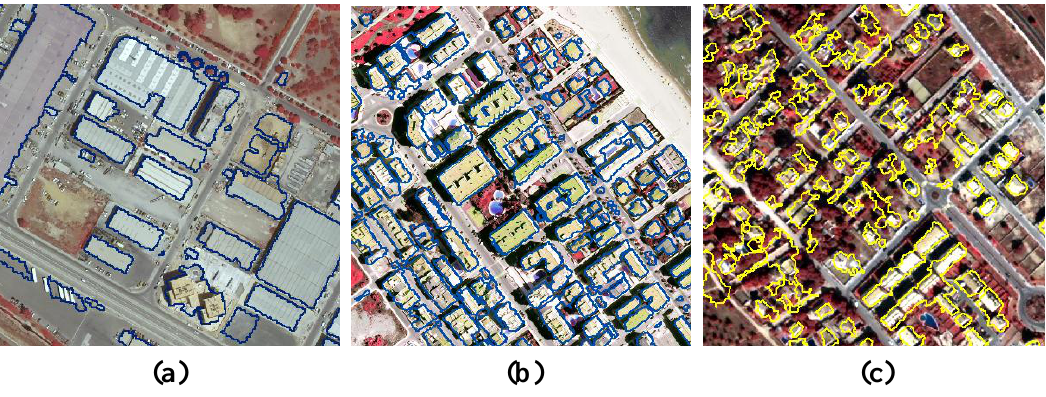
Figure 7. Detection examples of industrial buildings in Sagunto (a) , urban buildings in Oliva (b) and suburban buildings in Moncada (c) using the object-based classification approach.